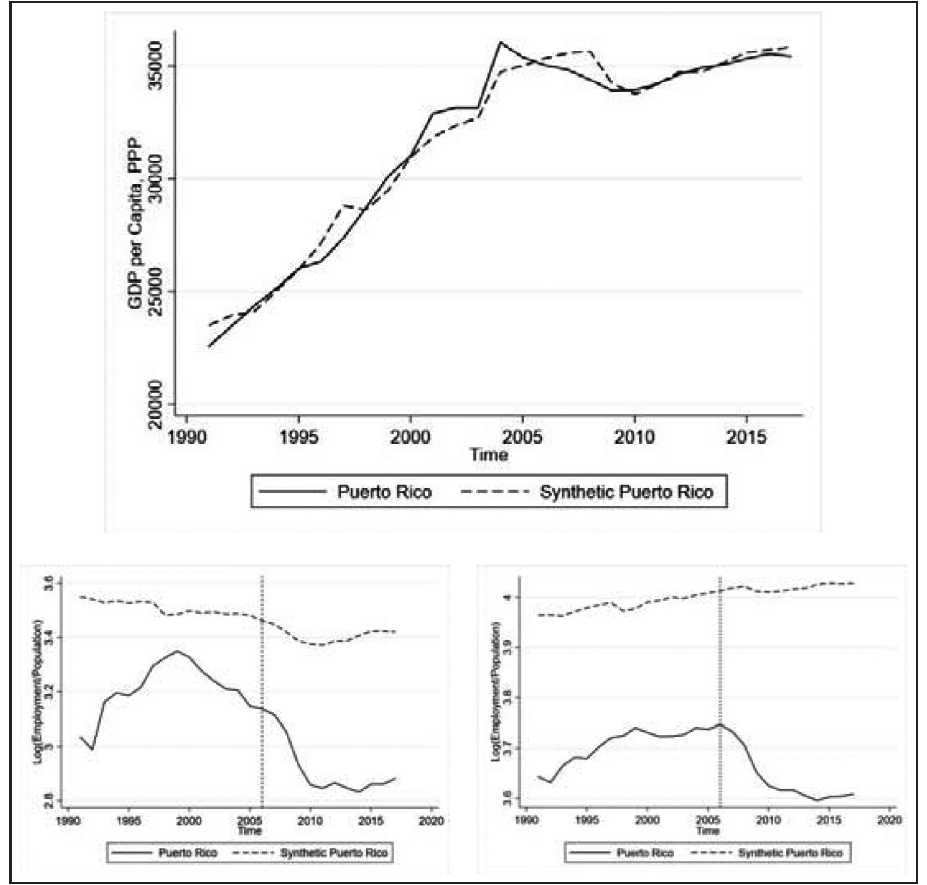
Comparisons Between Actual and Synthetic Puerto Rico (GDP